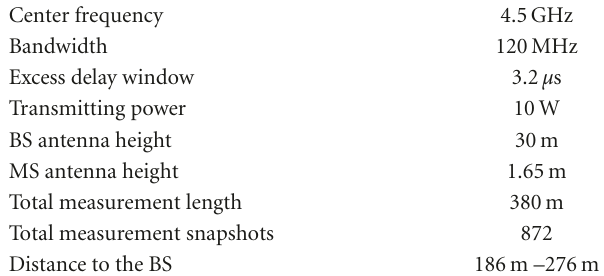
Figure 1: Measurement site map. Table 1: Measurement